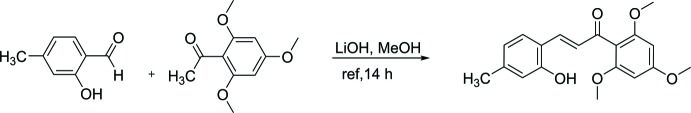
Reaction scheme for the synthesis of the title chalcone.